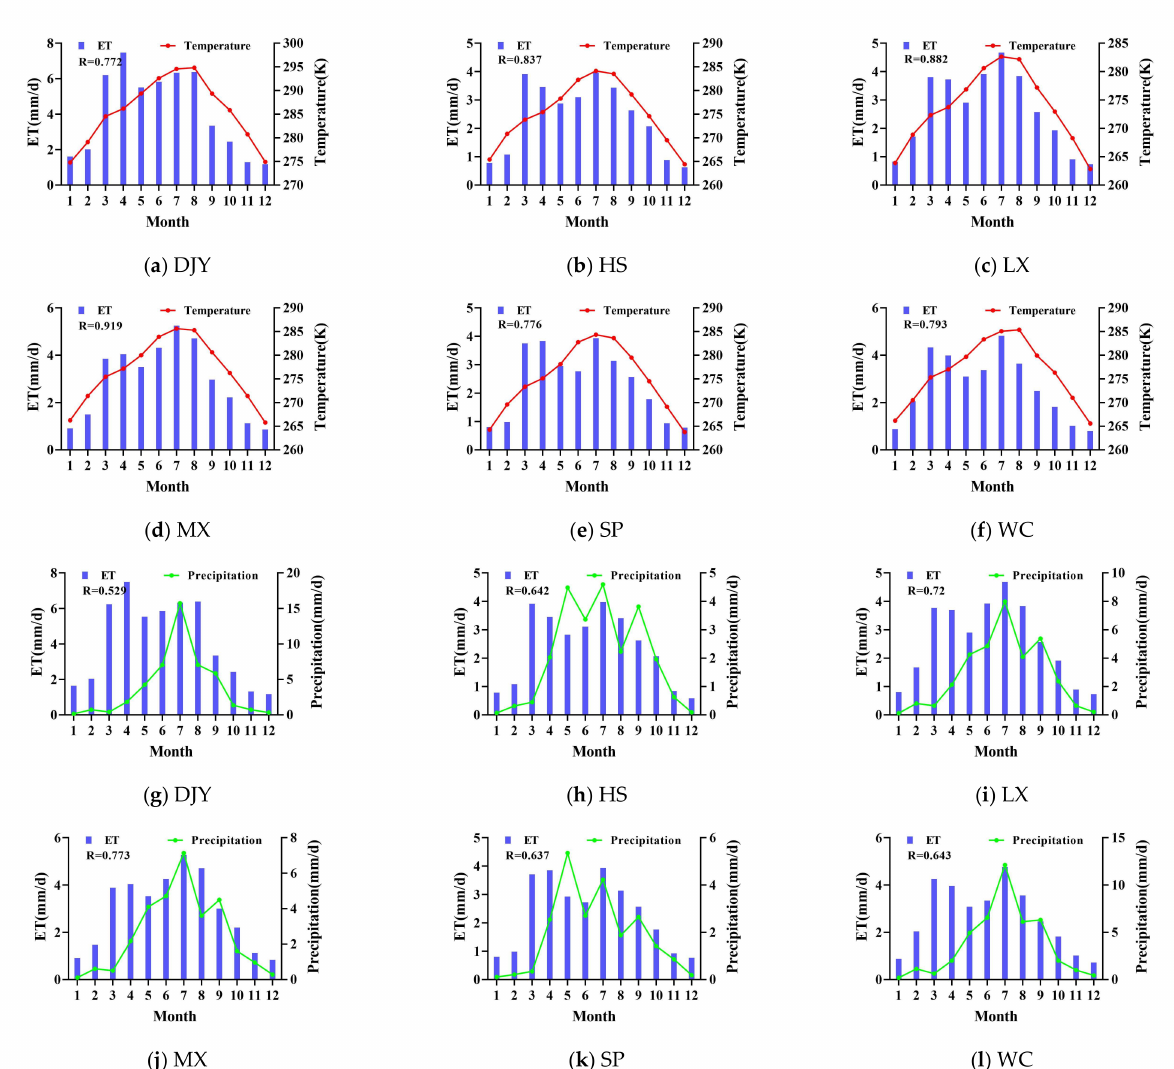
Figure 11. Correlation of daily average ET with temperature and precipitation for the simulated months. ( a – f ) are the correlations of daily average ET with temperature for DJY, HS, LX, MX, SP, and WC counties, respectively; ( g – l ) are the correlations of daily average ET with precipitation for DJY, HS, LX, MX, SP, and WC